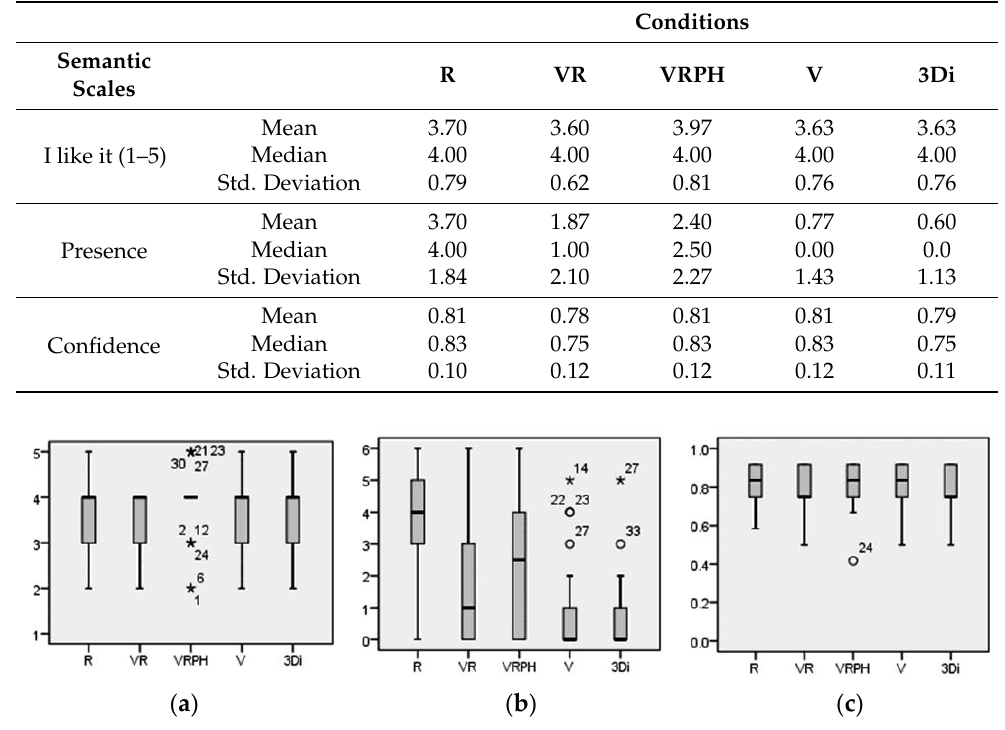
Figure 6. Box plot and histogram for the ( a ) “I like it” question, ( b ) sense of presence, and ( c ) con- fidence. Outliers outside 1.5 times the interquartile range above the upper quartile and below the lower quartile are represented by an open circle. Extreme outliers are marked with an asterisk. Table 4. Friedman’s Test—Grey areas depict statistically significant